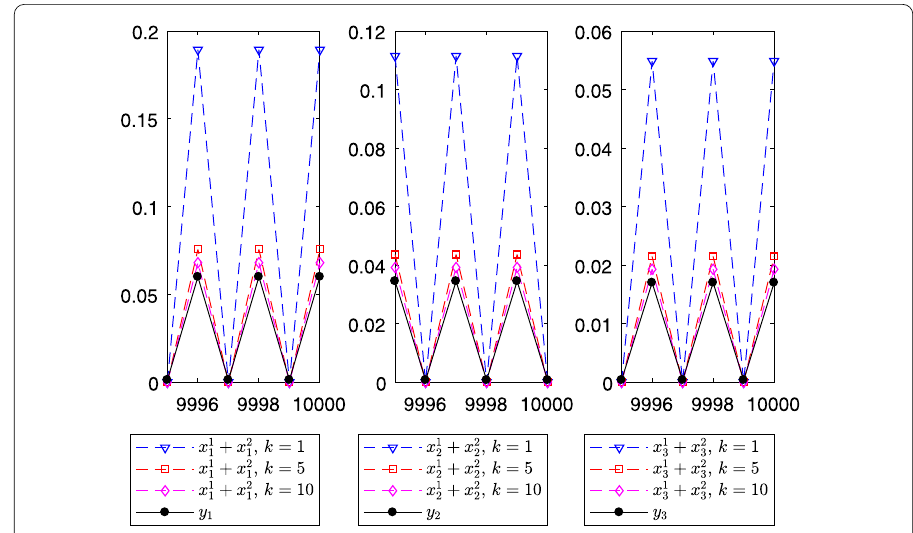
Figure 2 Comparison between the complete and the reduced systems. Total population corresponding to certain initial conditions for system (18) and for system (16) for three different values of k , i.e., k ∈ { 1,5,10 } . The simulations have been run until time t = 10 4 and only the last 6 times are shown. Parameter values: s 1 1 = 0.3, s 1 2 = 0.47, s 1 3 = 0.7, s 2 1 = s 2 2 = s 2 3 = 0.5, φ 1 = 3.8, φ 2 = 3.5, c 1 = c 2 = 1, d 1 = 5.3, d 2 = 5.6, v 1 1 = 0.3, v 1 2 = 0.25, v